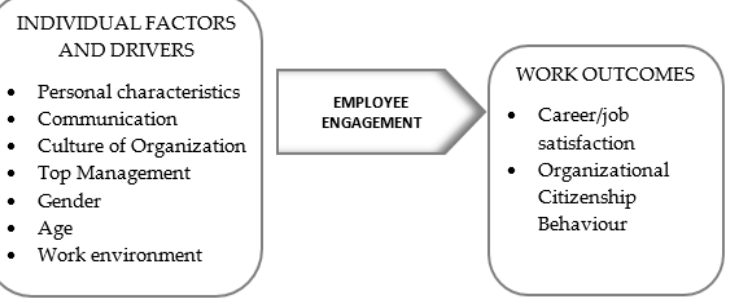
Figure 1 . Conceptual model of interlinked factors. Figure 1. Conceptual model of interlinked